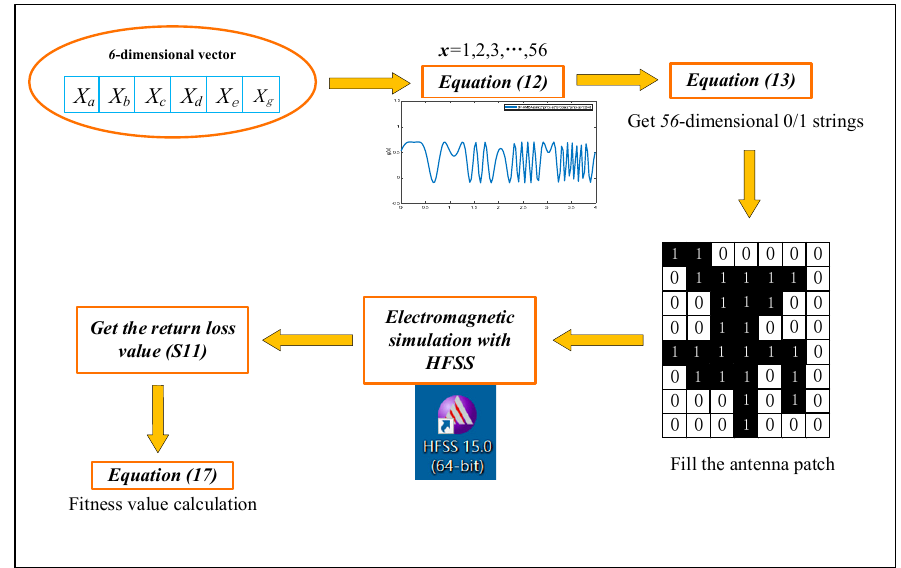
Figure 8. Schematic diagram of phase angle-modulated technology applied to antenna topology optimization.